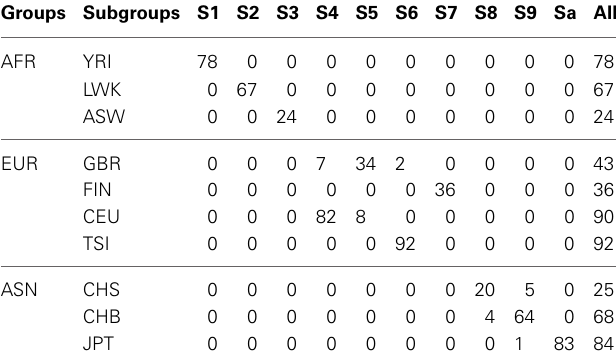
Table 4 | The numbers of subjects assigned to each of the 10 clusters based on the top 10 PCs using our new SSSC algorithm ( α = ˆ α , β = ˆ β ) with SSR = 0.5.